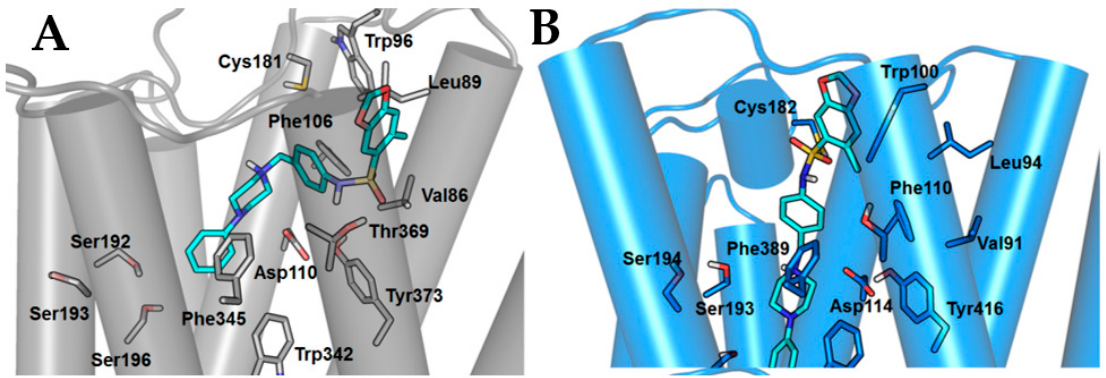
Figure 3. Interaction profile of compound 5a (light blue) on D 3 ( A -gray) and D 2 ( B -blue) receptors. The presence of substituents on the phenyl, linked to the piperazine ring, did not significantly modify the affinity for these